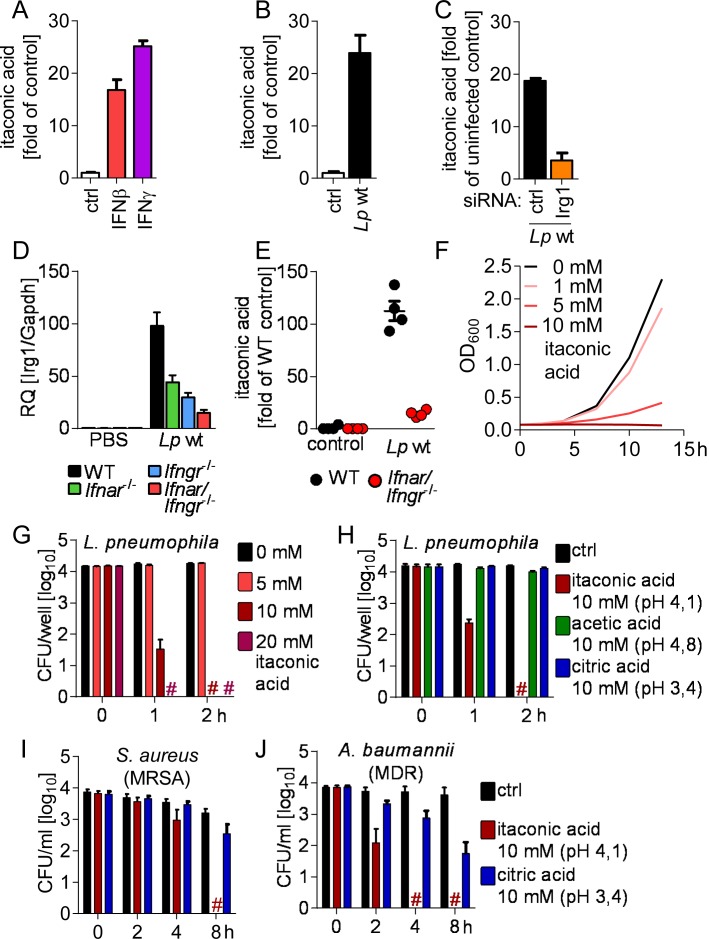
IRG1 mediates production of itaconic acid, which is bactericidal against L. pneumophila as well as multidrug-resistant Gram-positive and -negative bacteria.(A-C) Intracellular levels of itaconic acid were measured by GC-MS in BMMs after stimulation with 50 U/ml IFNβ or IFNγ for 16–18 h (A), infection with L. pneumophila for 24 h (B), and in BMMs transfected with siRNAs 24 h prior infection and infected with L. pneumophila for 24 h (C). (D, E) Irg1 expression (D) and itaconic acid levels (E) in lungs of L. pneumophila-infected or control mice measured by qRT-PCR or GC-MS, respectively, 2 d p.i.. (F) Itaconic acid was added to L. pneumophila in liquid culture and bacterial growth was assessed. (G-J) L. pneumophila, S. aureus (MRSA) and A. baumannii (MDR) were incubated in PBS containing itaconic acid or related acids, and numbers of viable bacteria were determined by CFU counting. (A-C) Data represent mean + s.e.m. of 3 (A) or 4 (B, C) experiments, done in sextuplicates pooled for GC-MS analysis. (D, E) Data represent mean + s.e.m. of 4 (E) or 5 (D) mice per group. (F) Representative graph of 3 independent experiments. (E, F) Data represent mean + s.e.m. of 2 (G) or 3 (H-J) experiments done in triplicates. # No viable bacteria were detected.